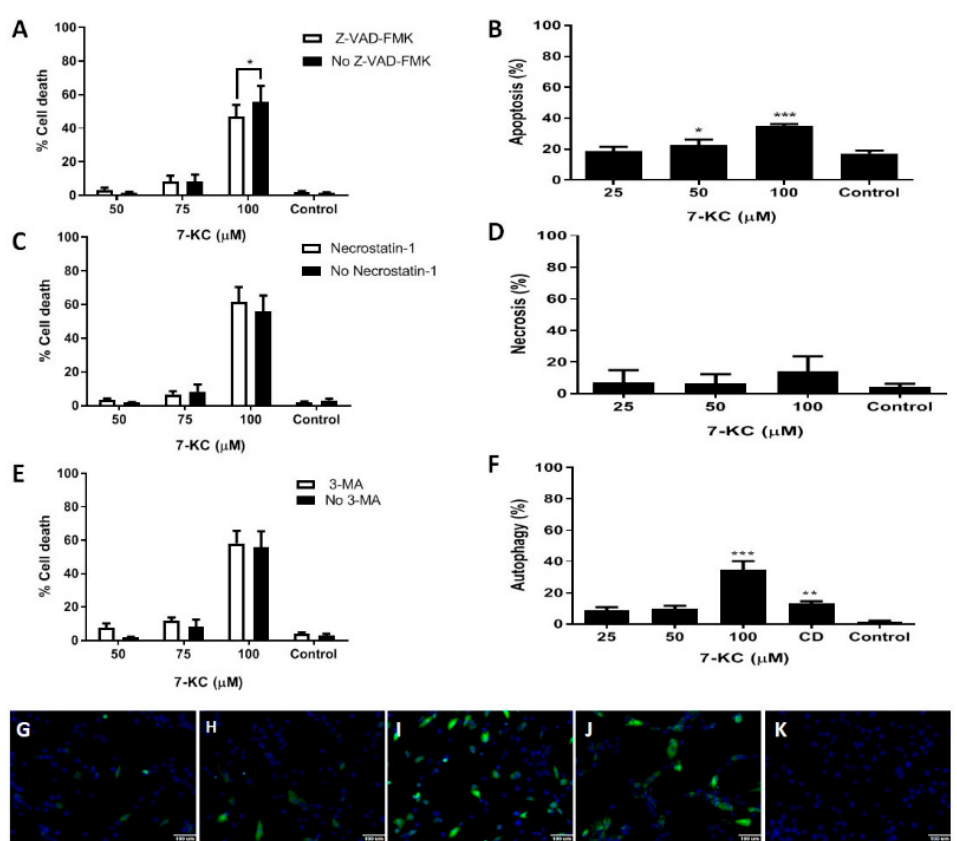
Figure 1. Apoptosis, necrosis, and autophagy in bone marrow-derived mesenchymal stem cells from patients with acute myeloid leukemia after 24 h 7-KC treatment. A : Cells were treated with or without Z-VAD-FMK for 3 h followed by incubation with 7-KC for 24 h. Cytotoxicity (apoptosis) was evaluated by Hoechst 33342 / propidium iodide staining. B : Percentage of apoptotic cells determined by the externalization of phosphatidylserine. C : Cells were treated with or without necrostatin-1 for 3 h followed by incubation with 7-KC for 24 h. Cytotoxicity (necrosis) was evaluated by Hoechst 33342 / propidium iodide staining. D : Percentage of cells with necrosis determined by propidium iodide. E : Cells were treated with or without 3-MA for 2 h followed by incubation with 7-KC for 24 h. Cytotoxicity (autophagy) was evaluated by Hoechst 33342 / propidium iodide staining. F : Percentage of cells with autophagy as evaluated by Premo Autophagy Sensor. CD: chloroquine diphosphate. G – K : Representative figures of LC3B-green fluorescent protein (GFP) chimera sensing of autophagy ( G : 25 µ M 7-KC; H : 50 µ M 7-KC; I : 100 µ M 7-KC; J : CD; and K : control). Data are mean ± SEM from three independent experiments in duplicate. * p < 0.05, ** p < 0.01, *** p <0.001. Scale bar, 100 µM.